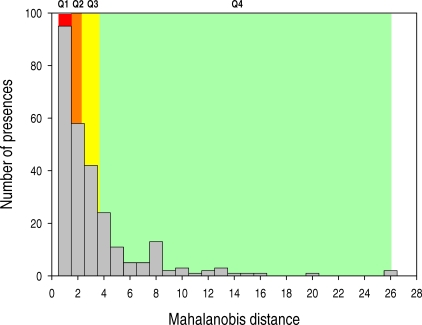
Number of Records of Mammoth Presence along the Climatic Suitability GradientThe suitable climatic conditions were split into quartiles (Q1, red; Q2, orange; Q3, yellow; Q4, green). The suitability gradient is measured using MD scores that represent the climatic difference between each of the woolly mammoth's records (radiocarbon calibrated for 42 ky BP, 30 ky BP, and 21 ky BP periods) and the average climatic conditions for the three periods combined. Increasing MDs represent decreasing suitability of the climate.